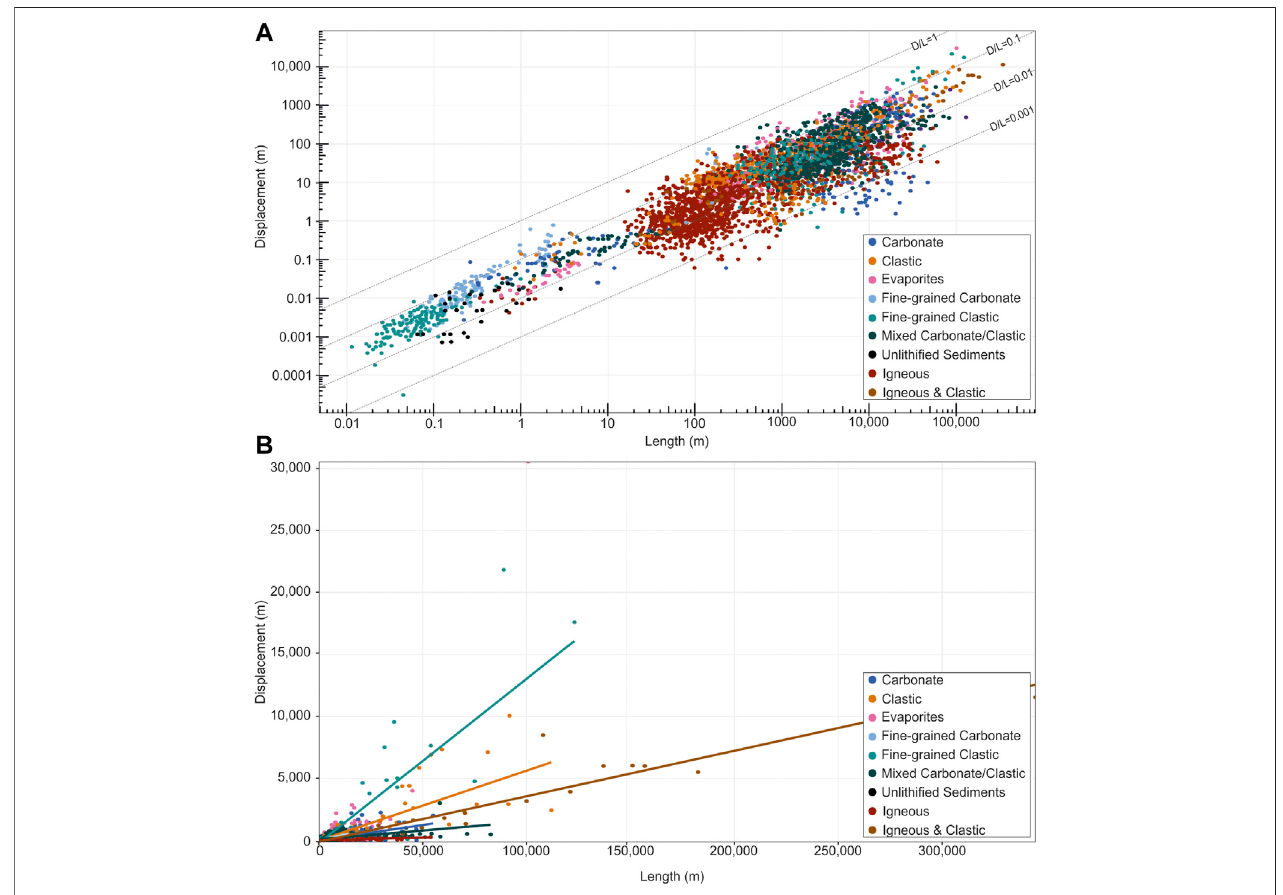
FIGURE8| Plotsshowingfaultlengthvs. displacementfornormalfaultswithhostrocks ofdifferentlithologiesincluded inourdataset,includingcarbonate,clastic, evaporites, fi ne-grained carbonate, fi ne-grained clastic, mixed carbonate/clastic, unlithi fi ed sediments, igneous, and igneous/clastic. (A) Data in log-log space. (B) Data not in linear